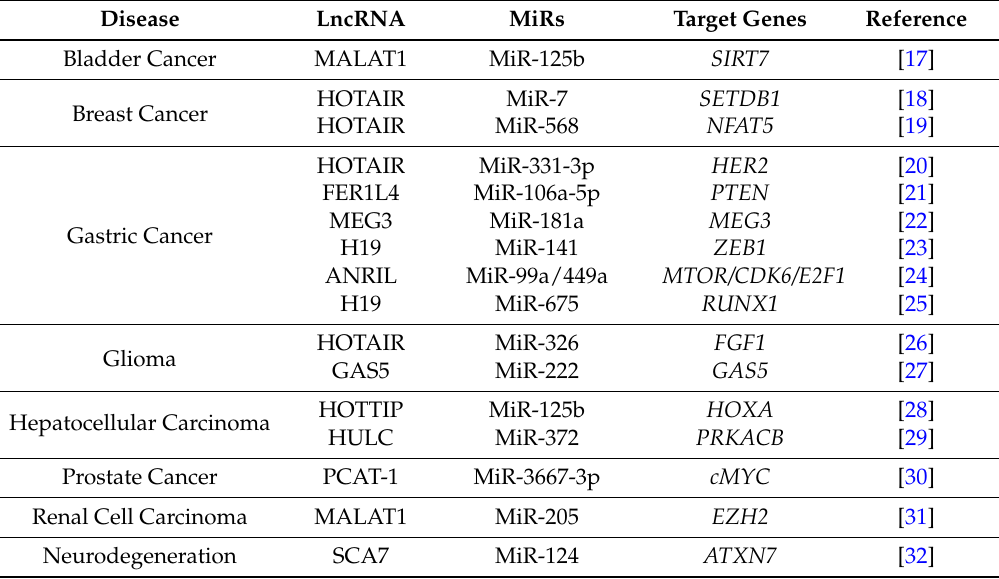
Table 1. Identification of long noncoding RNA-microRNA-target gene axis in cancers and neurodegeneration.